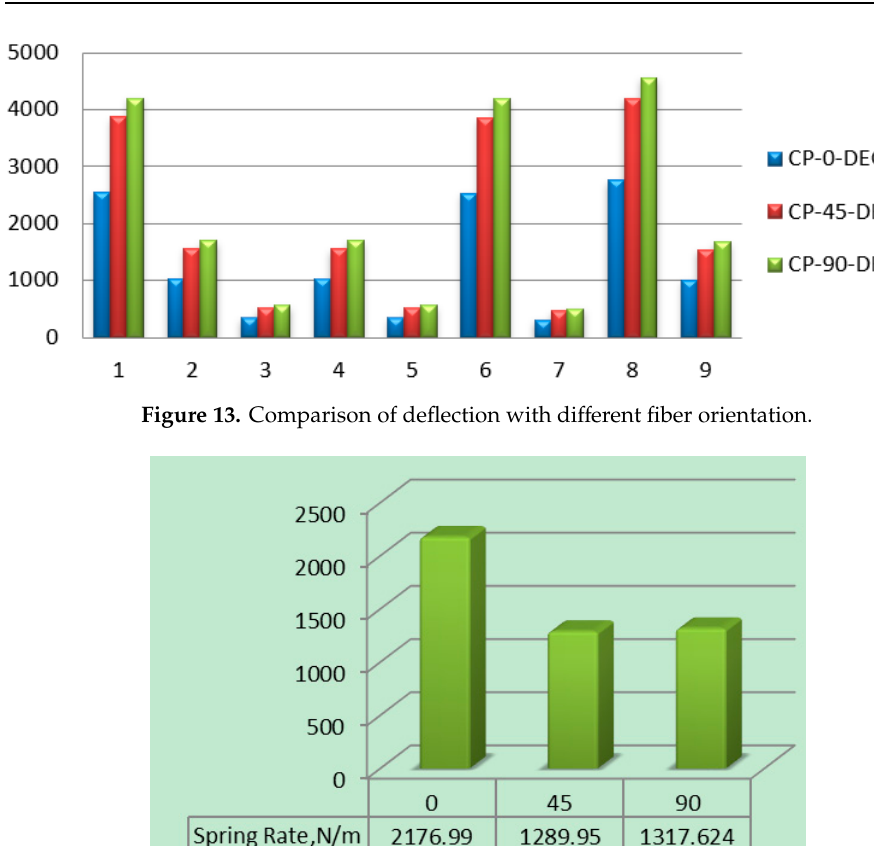
Figure 14. Spring rate of leaf spring for different fiber orientations.